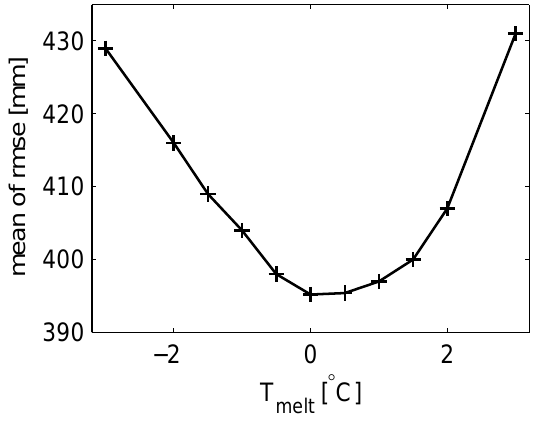
Fig. 1. Dependency of the mean of rmse model , cross of all glaciers on the prescribed value of T melt .